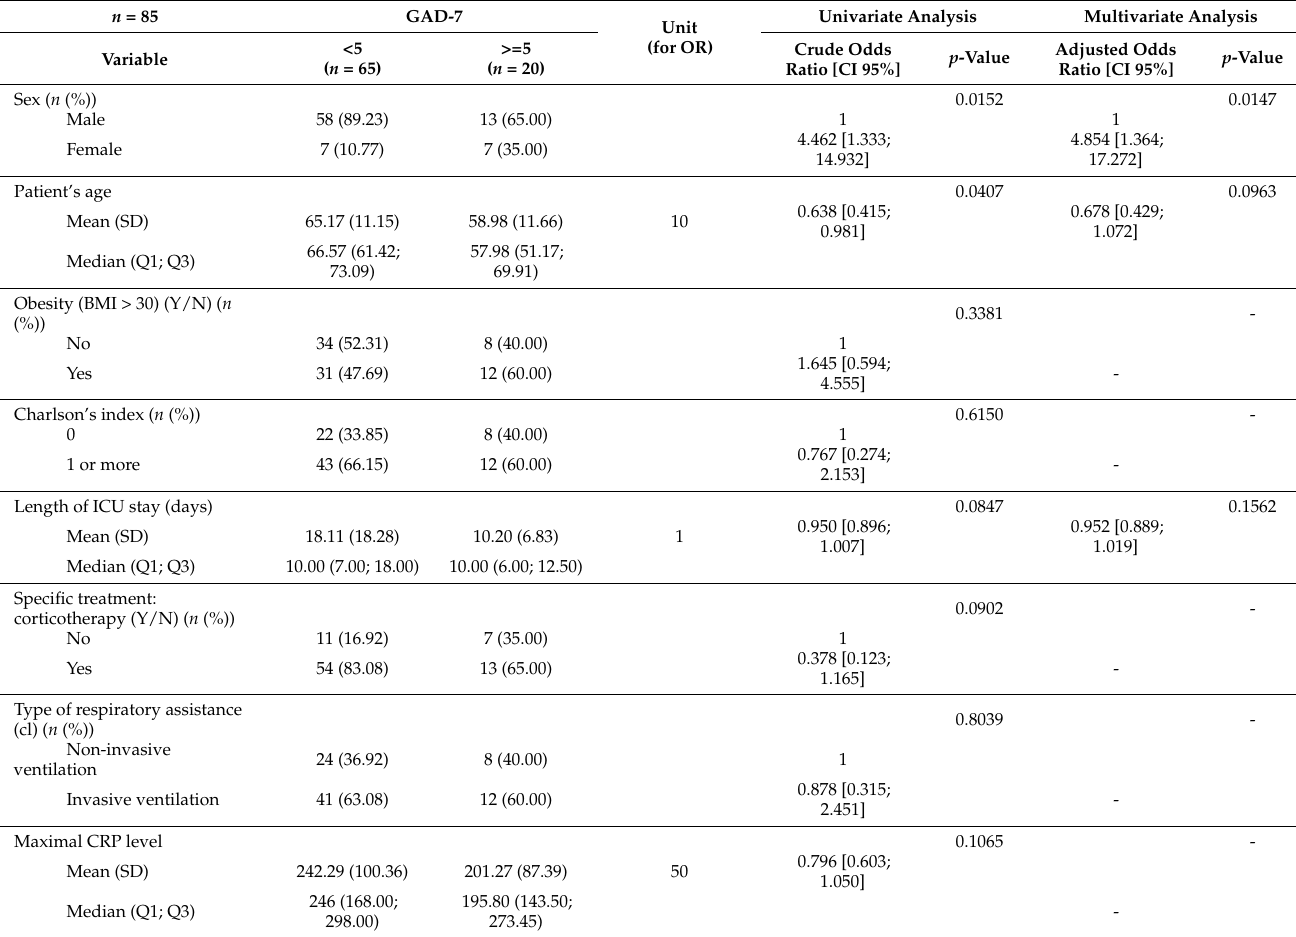
Table 6. Factors associated with